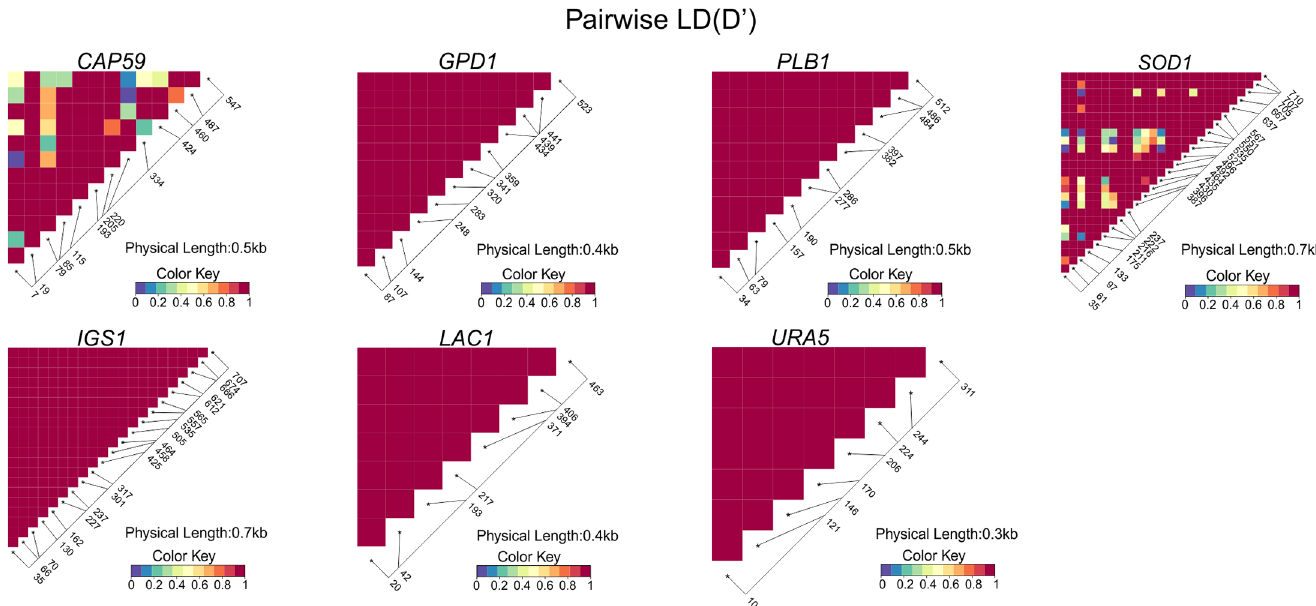
Fig 5. Linkage disequilibrium heat maps between polymorphic sites for all studied MLST loci ( CAP59 , GPD1 , PLB1 , SOD1 , IGS1, LAC1 and URA5 ). Pairwise D ’ metricises are represented by heat colours (Colour Key). Recombination amongst Brazilian VGII strains has been shown, as evidenced amongst four sites (0.7%) in the locus CAP59 and six sites (0.8%) in the locus SOD1 (Fisher ’ s Exact Test P-value (cid:1) 0.05).